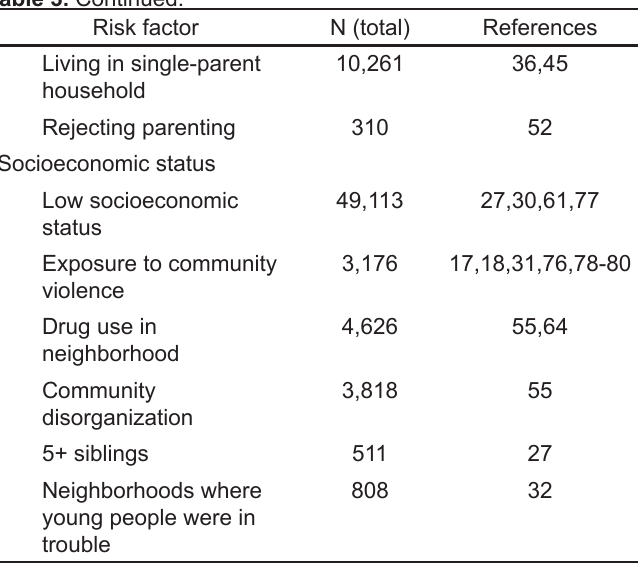
Table 3. Contextual risk